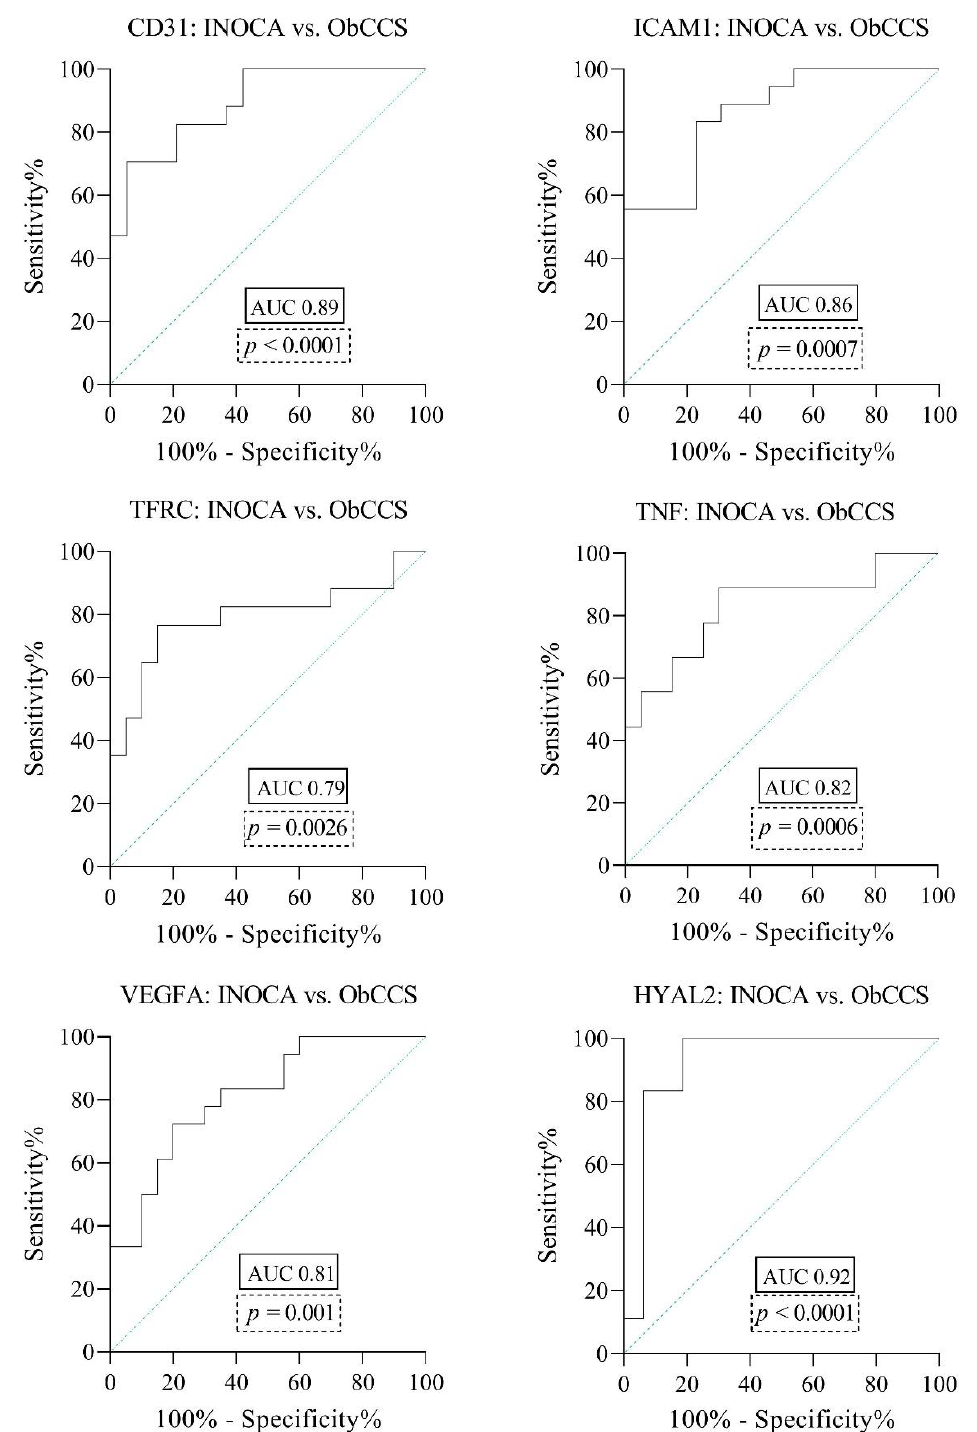
Figure 4. Receiver operating characteristic (ROC) curves for the prediction of INOCA/ObCCS based on the gene expression of CD31, ICAM1, TFRC, TNF, VEGFA, HYAL2. The area under the curve (AUC) equals 0.5 when the ROC curve corresponds to random chance and 1.0 for perfect accuracy. An AUC greater than 0.9 has high accuracy, while 0.7–0.9 indicates moderate accuracy and 0.5–0.7 low accuracy. CD31 = Platelet And Endothelial Cell Adhesion Molecule 1; HYAL2 = Hyaluronidase 2; ICAM1 = Intercellular Adhesion Molecule 1; TFRC = Transferrin Receptor; TNF = Tumor Necrosis Factor; VEGFA = Vascular endothelial growth factor A.